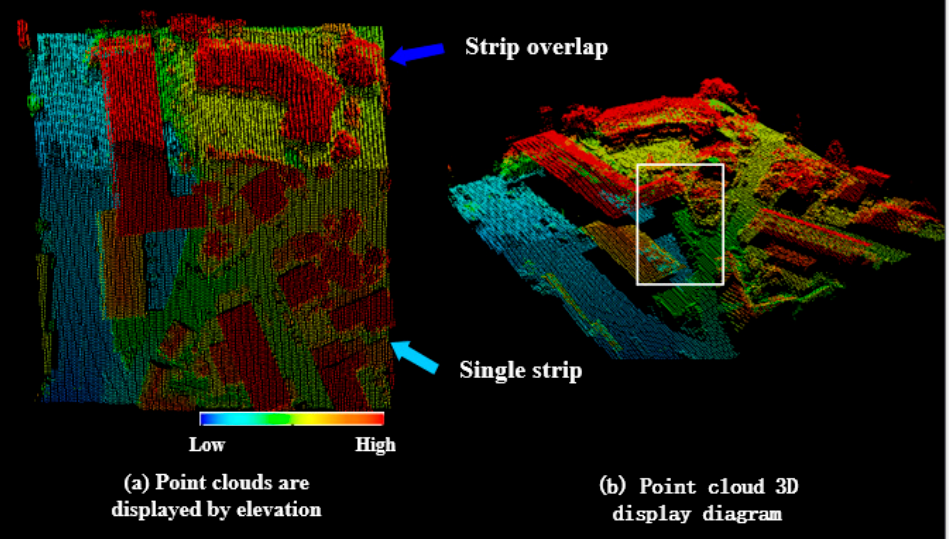
Figure 9. Schematic diagram of point-cloud classification error in specific region. (( a ): point cloud displayed with elevation; ( b ) indicates that there is a ditch where the box is framed, and the height difference between the two sides of the ditch is large, so the classification effect is not good.) Table 6. Vaihingen City datasets for each class of IoU (%).